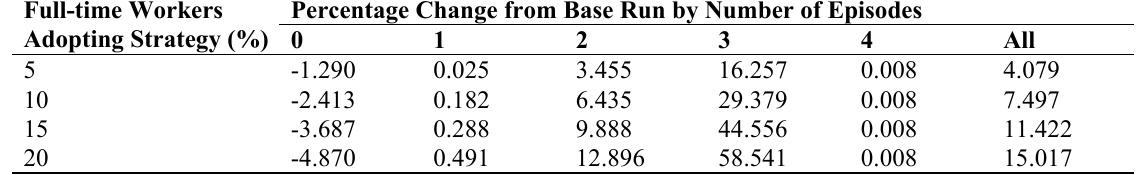
Table 9. Impact of the day off (Scenario 2) on the daily number of non-work, out-of- home activities estimated for the heads of households in the GTA, 1986 (Scott and Kanaroglou